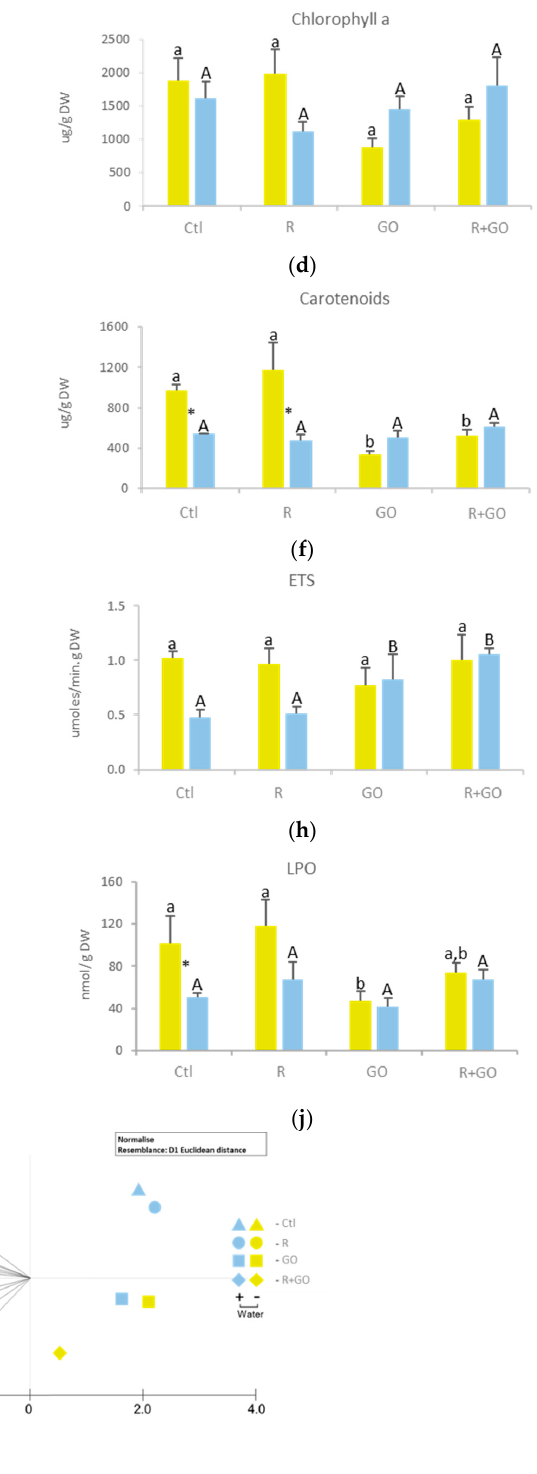
Figure 4. Biochemical parameters of the shoots of watered (light blue bars) or drought (light green bars) maize plants grown at different conditions (Ctl—no addition of graphene oxide nanosheets, no bacterial inoculation; R—no addition of graphene oxide nanosheets, inoculation with Rhizobium strain E20-8; GO—addition of graphene oxide nanosheets, no bacterial inoculation; R + GO—addition of graphene oxide nanosheets and inoculation with Rhizobium strain E20-8). ( a ) Soluble carbohydrates (CH); ( b ) insoluble carbohydrates; ( c ) proline; ( d ) chlorophyll a; ( e ) chlorophyll b; ( f )